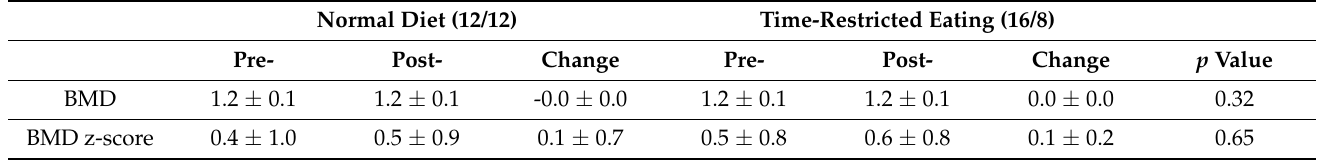
Table 5. Bone Mineral Density 1 .